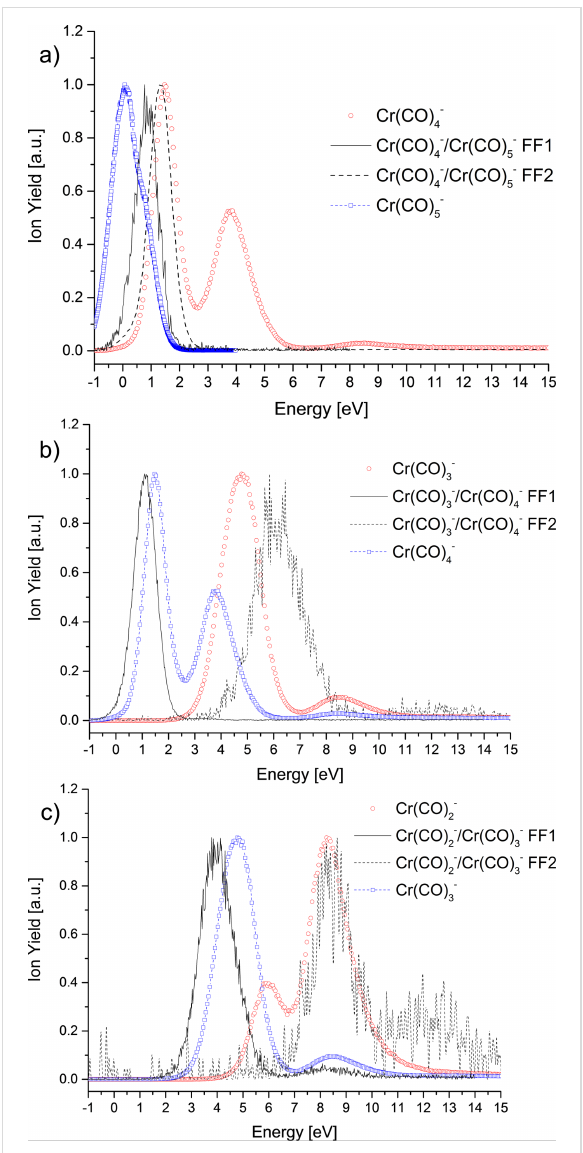
Figure 2: Electron energy dependence for the metastable decay reac- tions in the FF1 and the FF2, as well as the prompt ion yields for the involved fragment anions: a) for the reaction of Cr(CO) 5 − into Cr(CO) 4 − , b) for the reaction of Cr(CO) 4 − into Cr(CO) 3 − and c) for the reaction of Cr(CO) 3 − into Cr(CO) 2 − . Ion yields are